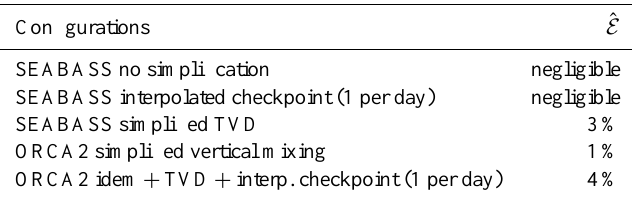
Table 1. Tangent validity tests for the bn2 routine (computation of the Brunt–Väisälä frequency), values of the first-order accuracy in- dex (cid:15) γ for several values of the perturbation amplitude γ .